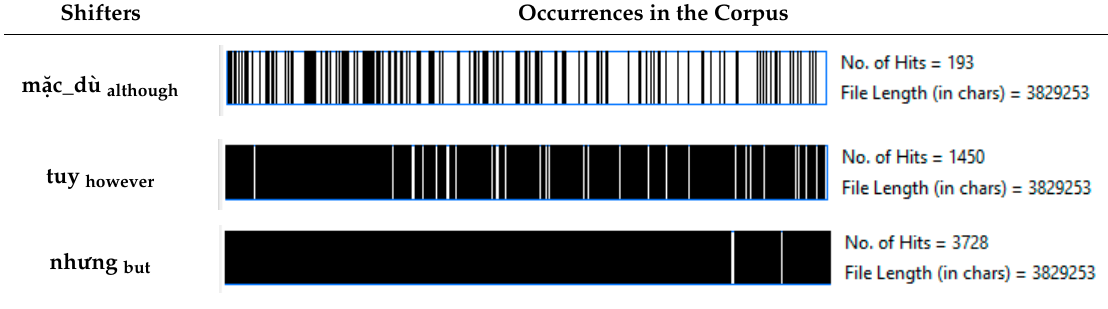
m ặ c_d ù although